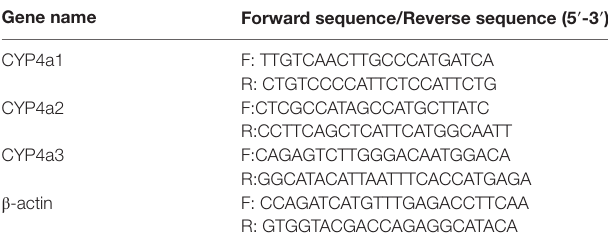
TABLE 2 | Synthetic primers for real-time